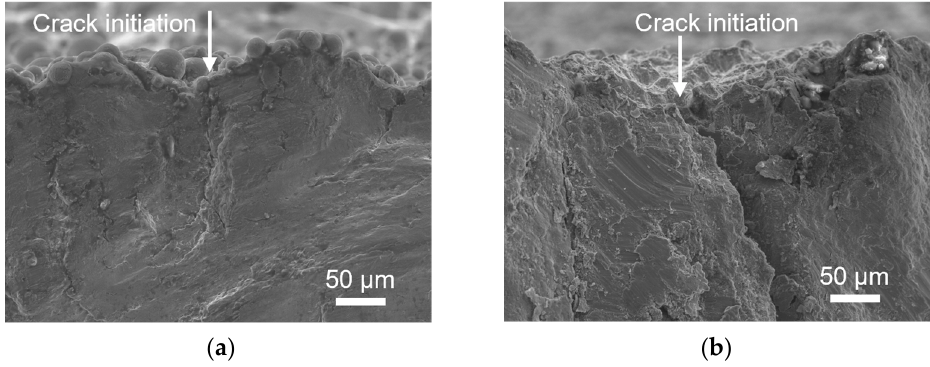
Figure 16. Fractured surfaces observed using scanning electron microscope: ( a ) as-built specimen; ( b ) specimen treated with laser cavitation.